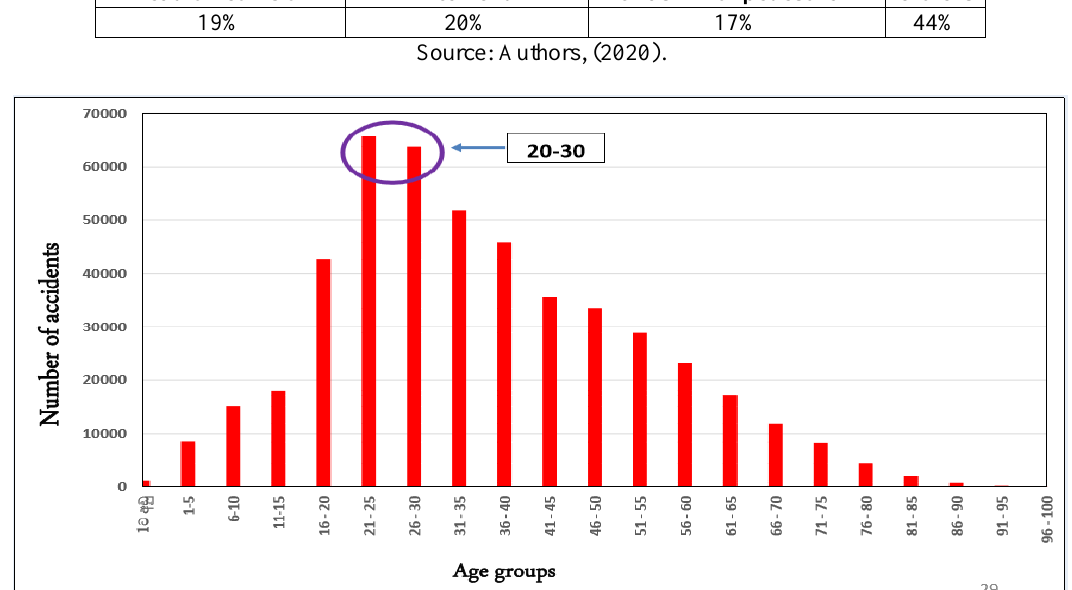
Figure. 12: Variation of number of accidents by age of victim.